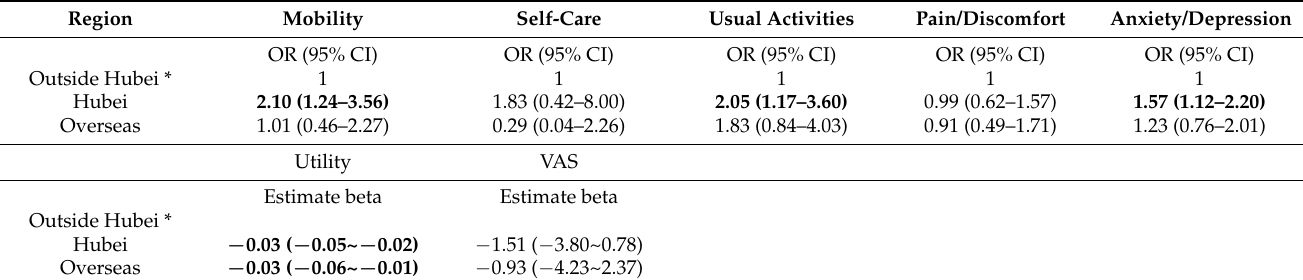
Table 5. Multiple logistic regression analyses on having any problems in EQ-5D dimensions and multiple linear regression analyses on EQ-5D-5L utility and VAS (visual analogue scale) scores, by region, controlled for sex, age group, education level, marital status, and chronic